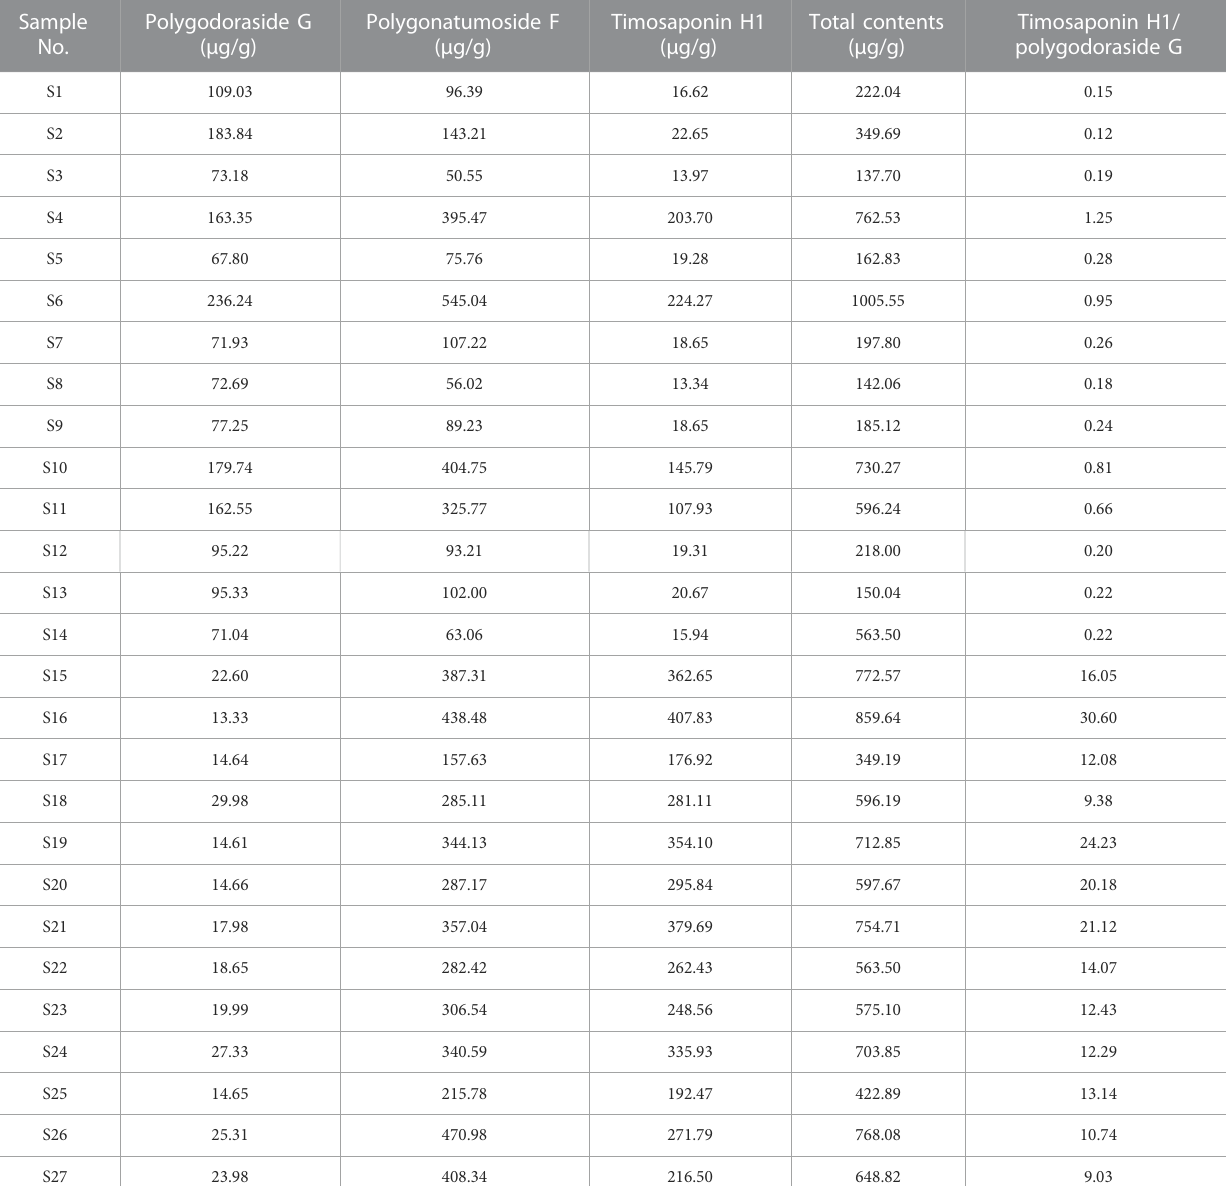
TABLE 3 Contents of three compounds in 27 batches of PO and the ratio of timosaponin H1/polygodoraside G. Sample